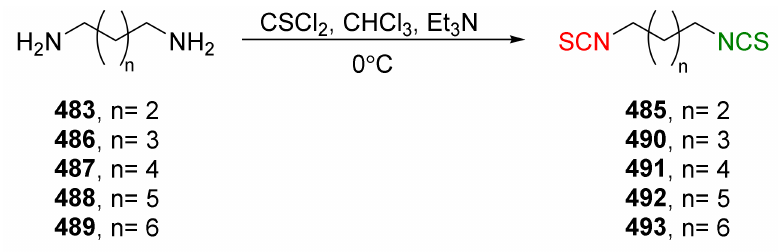
Figure 58. Synthesis of diisothiocyanates 485 , 490 – 493 . The growth-inhibitory activity of synthesized diITCs 485 , 490 – 493 , against